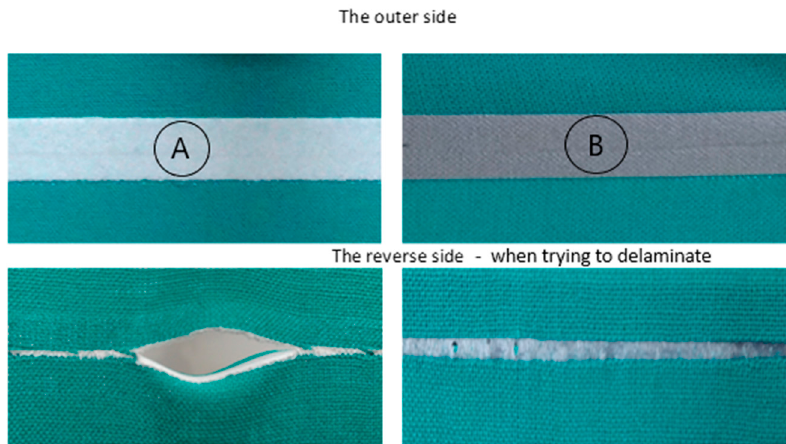
Figure 2. Laminated seams during to delamination tests with tapes ( A ) and ( B ).